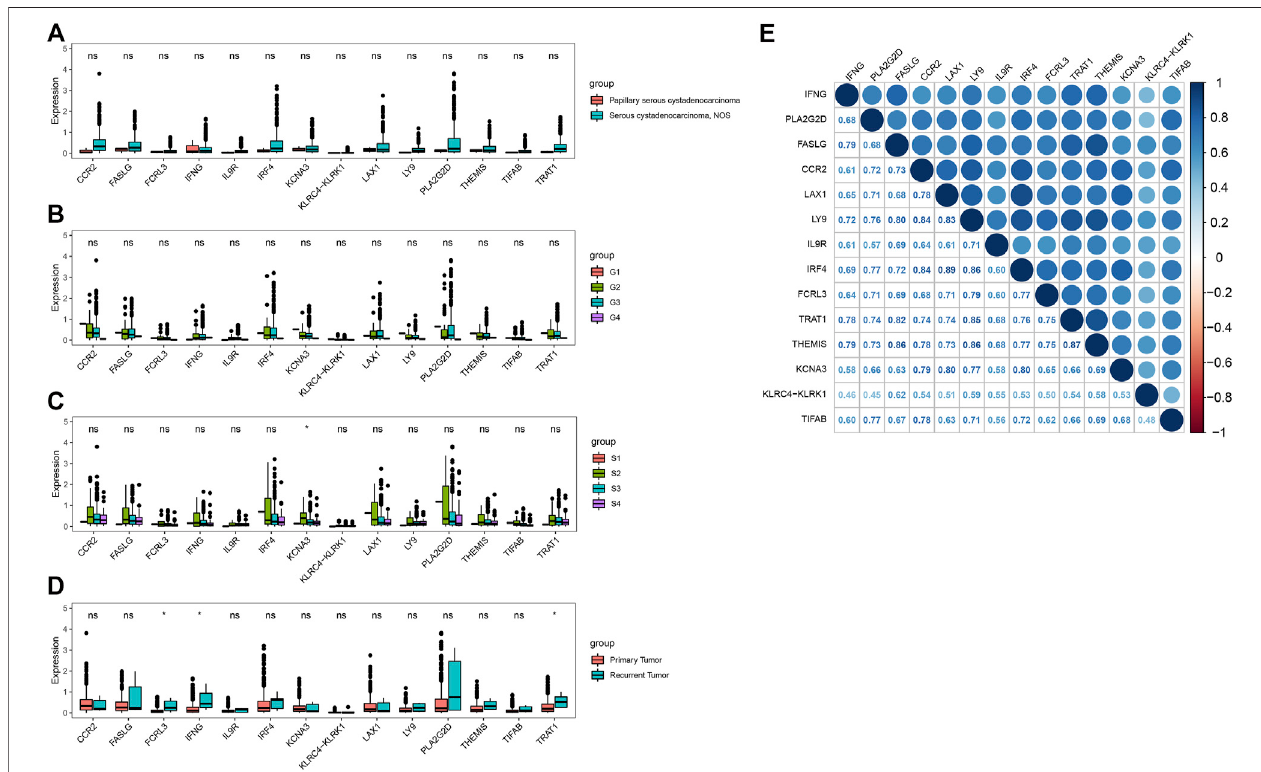
FIGURE 4 | Correlation analysis of the key genes in OV. (A – D) Correlations of key genes with disease type, grade, stage and sample type. (E) Correlation analysis between key genes (* p < 0.05; ns, no signi fi cance).